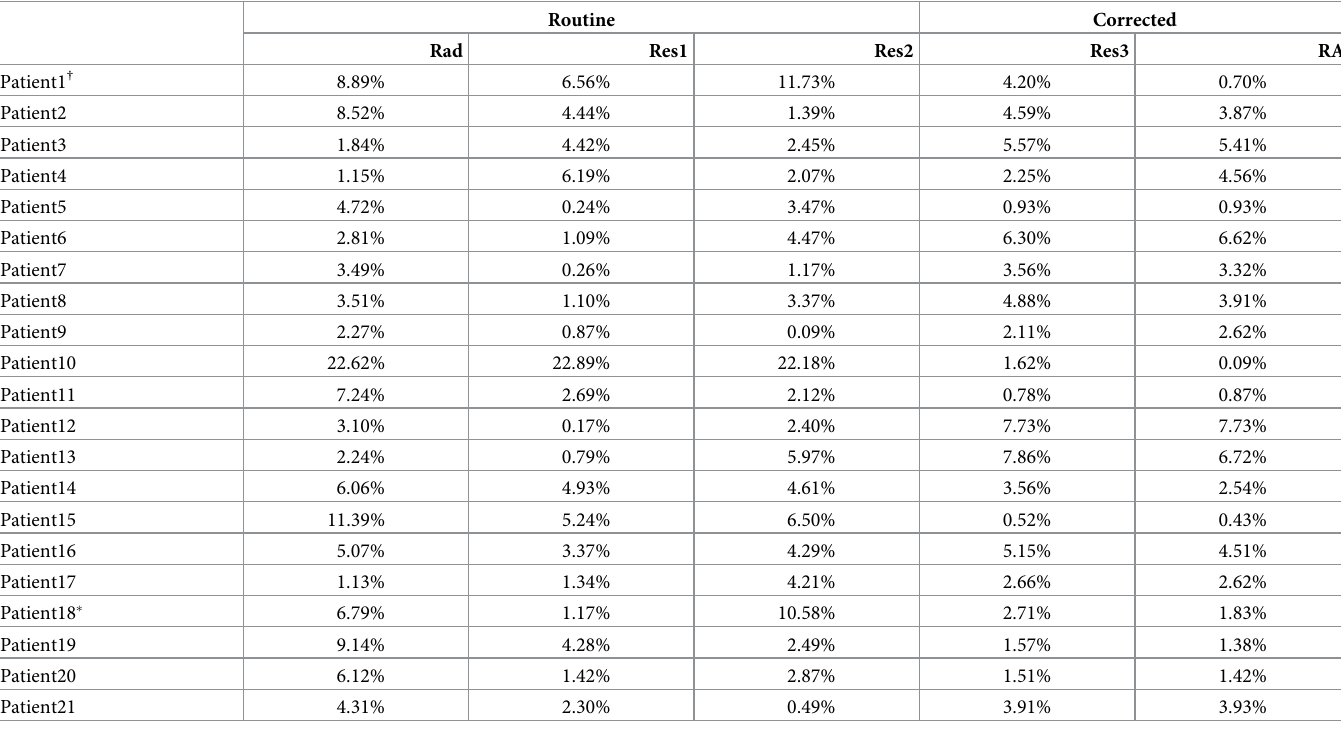
Fig 7. Box plots showing mean absolute inter-observer relative volume difference for routine and corrected automatic segmentations. See Table 3 for RVE values of all observers. https://doi.org/10.1371/journal.pone.0217228.g007 Table 3. Per patient relative volume error for routine and corrected automatic